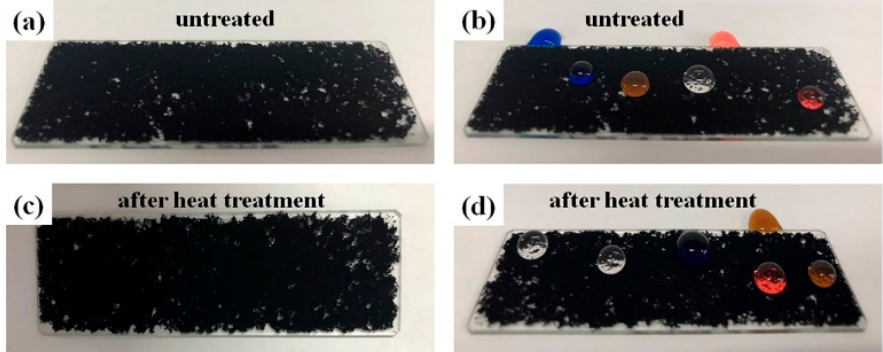
Figure 6. ( a ) The picture of the superhydrophobic composite coatings; ( c ) the picture of the super- hydrophobic composite coatings after 3 days of heat treatment at 200 °C; ( b , d ) the picture of water drops on the composite coatings of ( a , c ), respectively. Water drops were dyed blue by methylene blue, dyed orange by coffee, and dyed red by methyl orange in acids.